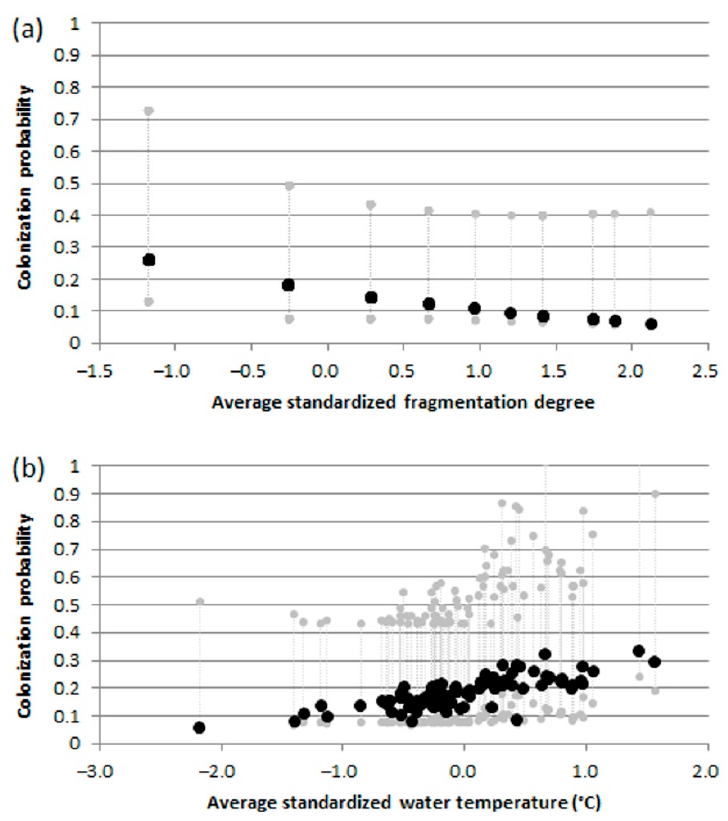
Figure 10. Barbus barbus : effects of fragmentation degree ( a ), and water temperature ( b ) on colonization probabilities from the best informative models. Dashed gray lines indicate upper and lower 95% confidence intervals.